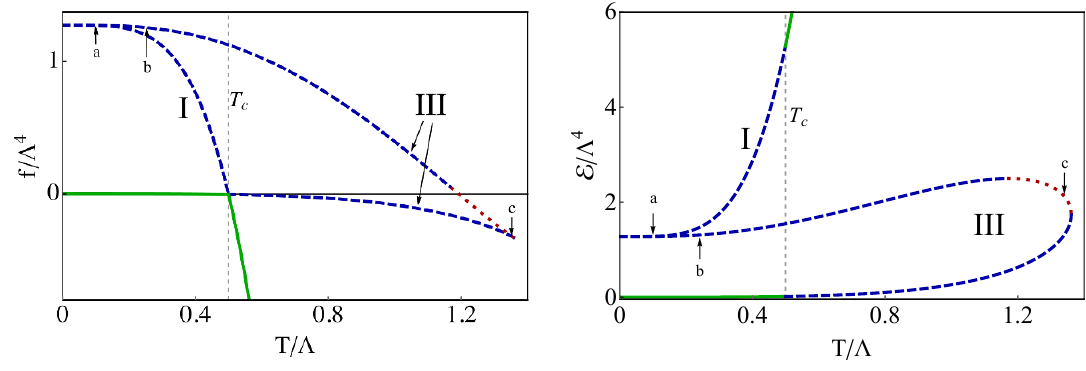
Figure 4 . Phase diagram of the CFT 1 . Left: free energy density versus temperature. Right: energy density versus temperature. The dashed vertical line corresponds to the phase transition temperature T c = (cid:3) ’ 0 : 499. Locally unstable regions are shown in dotted red, locally stable but globally unstable regions are shown in dashed blue, and globally thermodynamically preferred regions are shown in solid green. The labels \a", \b" and \c" indicate the thermal states whose dual gravity solutions are displayed in (cid:12)gure